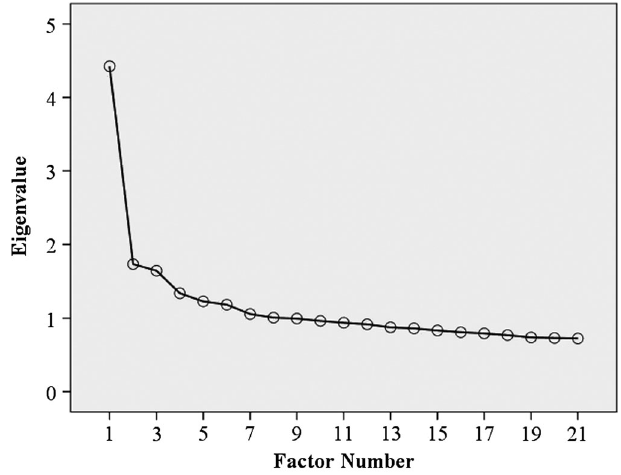
FIG. 1. Scree plot for the 30 EBAPS items (post-test). Factors after 21 were